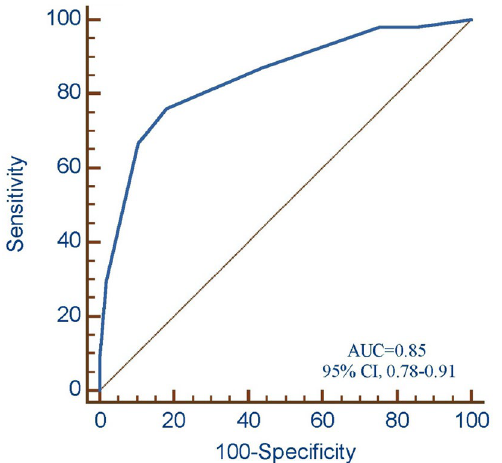
Figure 2. Receiver operating characteristic curve analysis for the risk scores in tuberculosis patients with